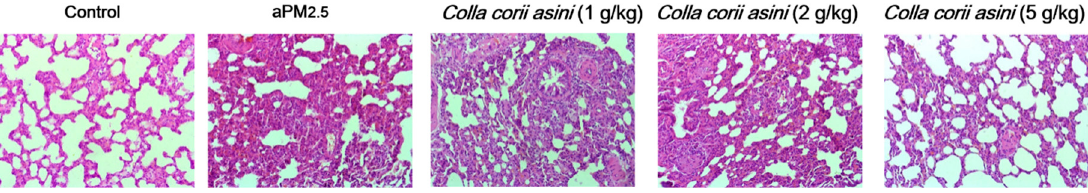
Figure 4. Colla corii asini prevented aPM 2.5 -induced inflammation. H&E-stained (×200) lung sections from